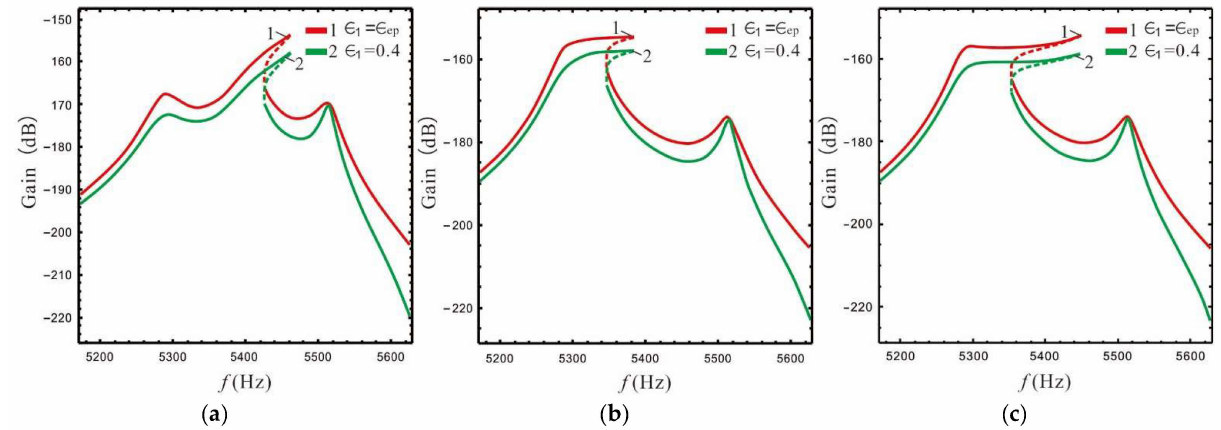
Figure 13. The shape of the frequency response curve is affected by FCP: ( a ) ω x = 5400 × 2 π k d =